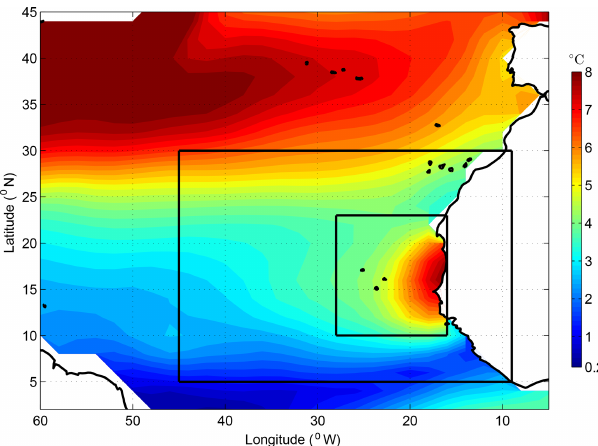
Figure 1. Amplitude of the SST seasonal anomalies in the western tropical North Atlantic. SST data are from the ERSSTv3b data set averaged between 1975 and 2005. The two black boxes show the extended and zoomed regions, respectively, on which the statistical classifications were performed (see text for